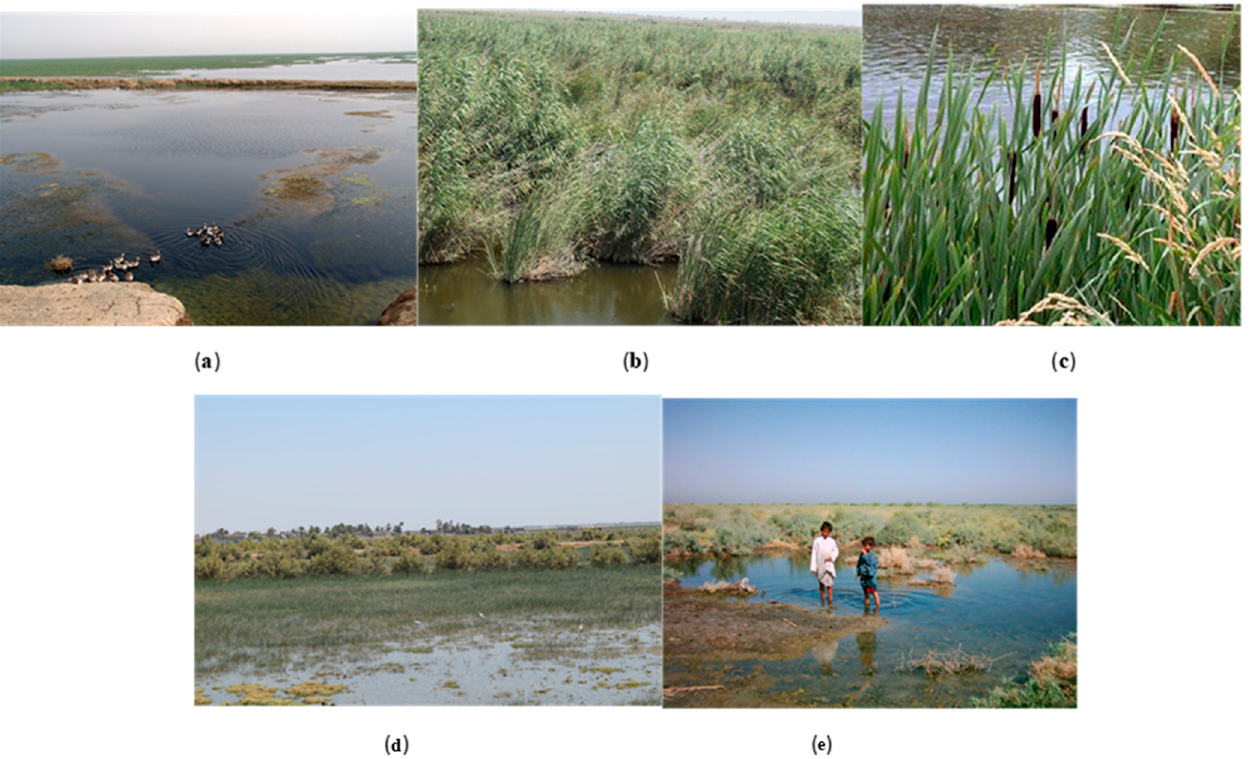
Figure 3. Photographs of land cover for the study area of typical habitats of the Al Hammar marsh ( a ) Water with pondweeds. ( b ) Phragmites australis community. ( c ) Typha domigensis community. ( d ) Schoenoplectus litoralis community. ( e ) Vegetation of wet soils. (Photos by Al-Maliki). Table 2. Comparison of land cover categories based on remote sensing in this study and the habitat types of the Al Hammar marsh